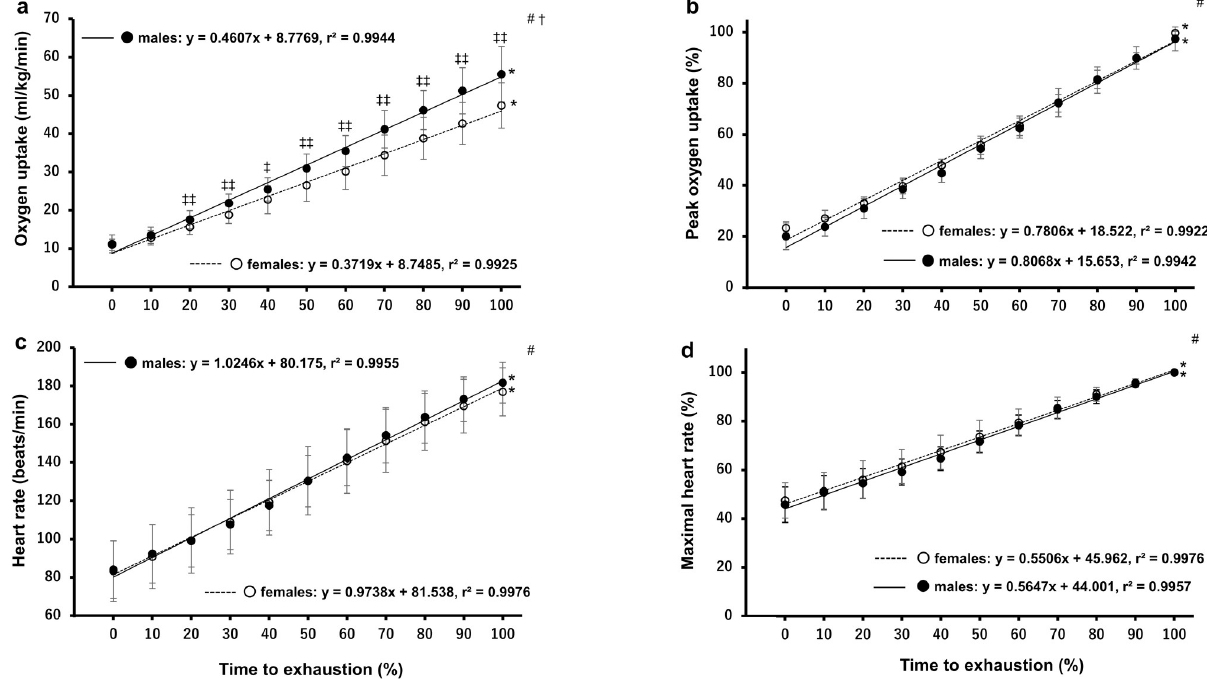
Fig 2. Time course changes of oxygen uptake and heart rate in response to the continuous ramp-incremental cycling test. Fig 2A and 2B show oxygen uptake response as a function of percentage of TTE expressed as absolute (left upper panel) and relative (right upper panel) responses, respectively. Fig 2C and 2D show heart rate response as a function of percentage of TTE expressed as absolute (left lower panel) and relative (right lower panel) responses, respectively. # Indicates a main effect of time in the two-way mixed ANOVA (p < 0.001). † Indicates a time-by-group interaction effect in the two-way mixed ANOVA (p < 0.001). � Indicates a main effect of time in the one-way repeated ANOVA (p < 0.001). ‡‡ Indicates greater than female athletes (p = 0.0097 to 0.0002). ‡ Indicates greater than female athletes (p = 0.017). Significant differences between each of timepoints are not shown for